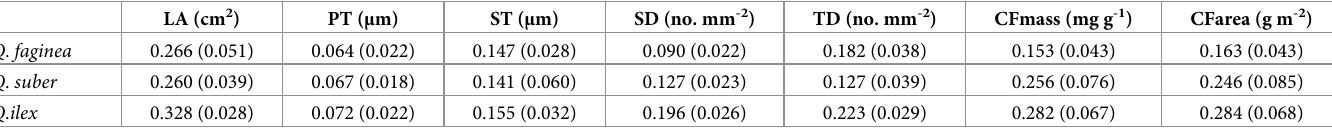
Table 4. Leaf plasticity indices [(maximum value-minimum value)/maximum value] for the leaf traits showing significant differences between east and west canopy orientations. Data are means (SE in parentheses) from five different